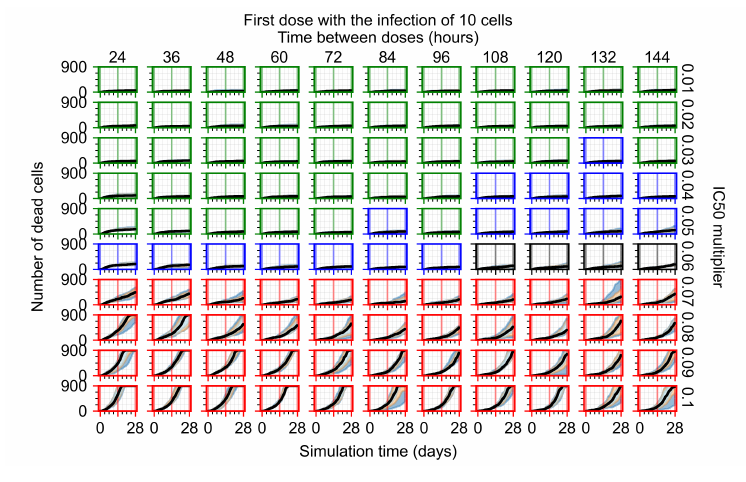
Figure A8. Dead population.